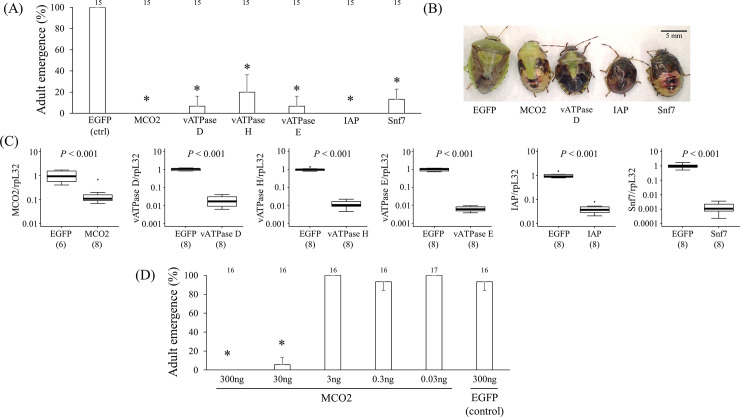
Effects of RNAi knockdown on fifth-instar nymphs.(A) Adult emergence rates of fifth-instar nymphs injected with dsRNA against each target gene. Newly molted fifth-instar nymphs were injected with 3 μL of dsRNA at a concentration of 100 ng/μL. Adult emergence rates among 5 nymphs were determined. The experiment was performed in three parallels and the mean adult emergence rates with standard deviations are shown. Numbers above bars show total sample sizes. Statistically significant differences compared with EGFP injection is shown by asterisks (t-test: P < 0.001). (B) Normal adult and typical carcasses due to RNAi of PsMCO2, PsvATPase subunit D, PsIAP and PsSnf7. Fifth-instar nymphs injected with dsRNA of PsMCO2 and PsvATPase died during molting, whereas nymphs injected with dsRNA of PsIAP and PsSnf7 died independent of the molting events. Scale bar shows 5 mm. (C) Silencing efficiency of RNAi by injection of 300 ng dsRNA into fifth-instar nymphs. RNA was extracted from nymphs 2 days after injection, and the expression level of each gene was quantified. The numbers in parenthesis are sample sizes. Statistically significant differences were evaluated by t-test. The mean expression level of the control treatment (EGFP) was designated as 1.0. (D) Effects of different concentrations of dsRNA on RNAi in fifth-instar nymphs, in which dsRNA targeting PsMCO2 or EGFP was injected. Newly molted fifth-instar nymphs were injected with 3 μL of dsRNA solution at different concentrations (100, 10, 1, 0.1, or 0.01 ng/μL). Nymphs injected with 30 ng or more dsRNA showed inhibition of cuticle sclerotization and pigmentation. Experiments were performed in three parallels, and the total numbers of sample sizes are shown above the bars. Statistically significant differences compared with EGFP injection is shown by asterisks (t-test: P < 0.001).